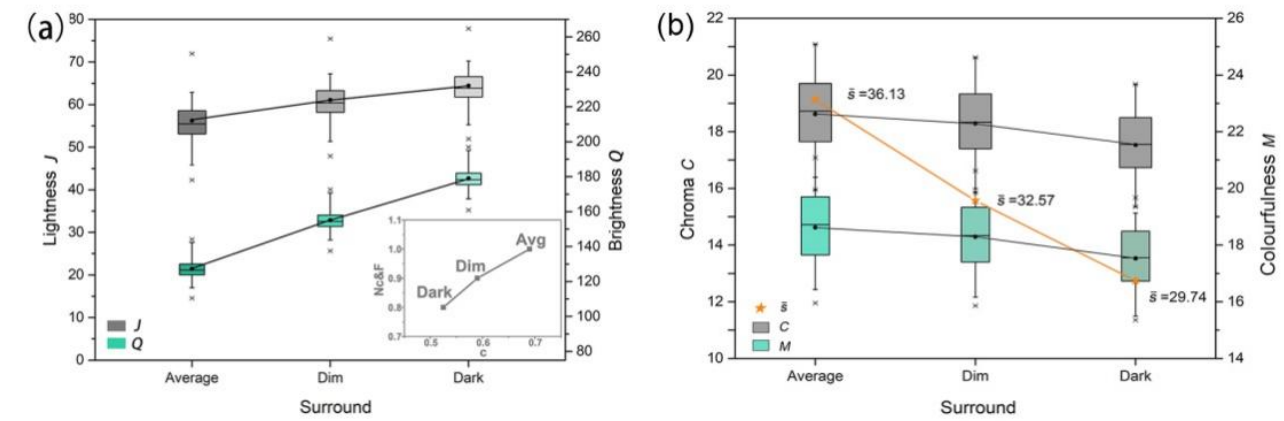
Figure 9. Predicted J , Q , C , M , and s values under different surrounds. ( a ) J and Q increase with the darkening of the surround. ( b ) C , M , and s decrease with the darkening of the surround.